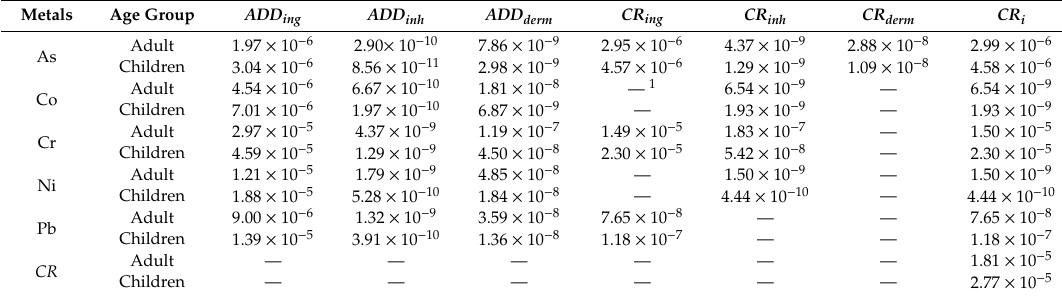
Table 5. Daily exposure and carcinogenic risk index for adults and children with PHEs and pathways in 0–40 cm soil